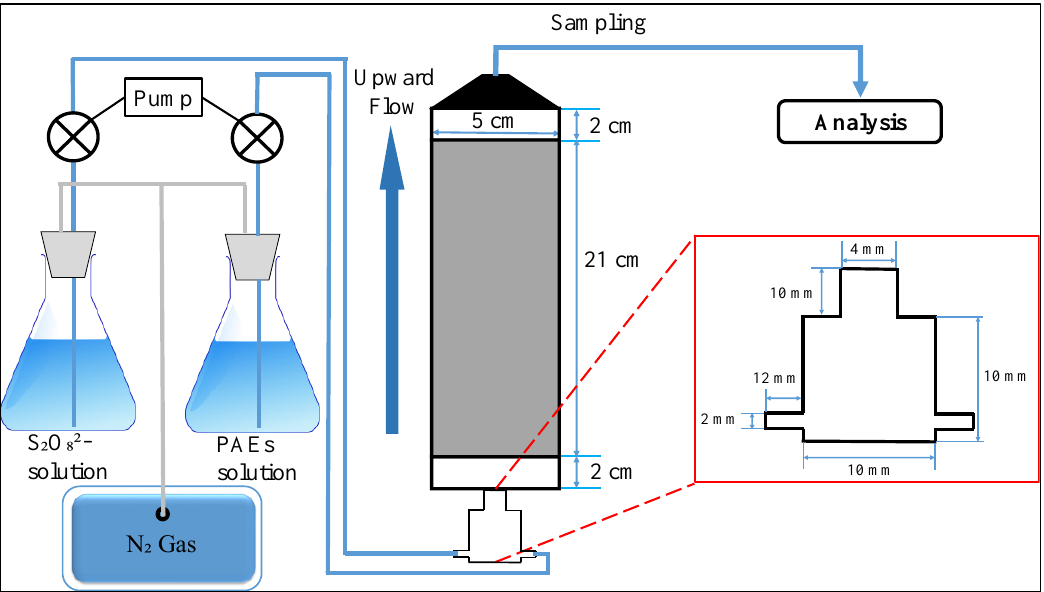
Figure 1. Schematic diagram of the experimental apparatus.